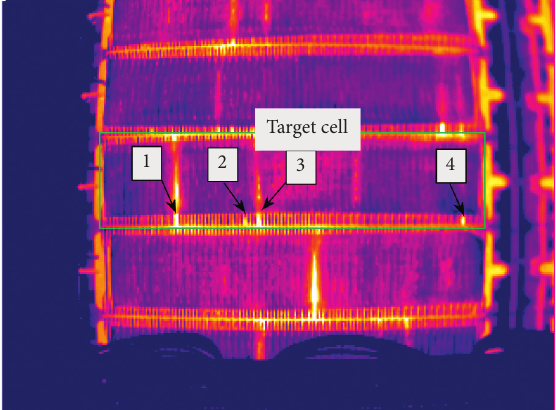
Figure 11: Target cell in an IR